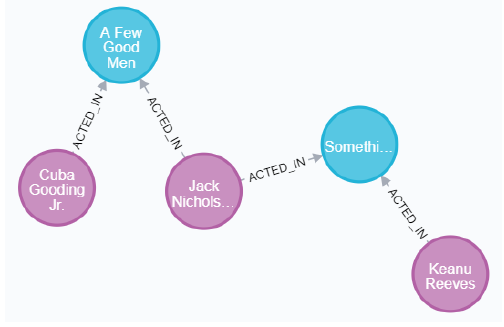
Figure 6. Shortest path query.